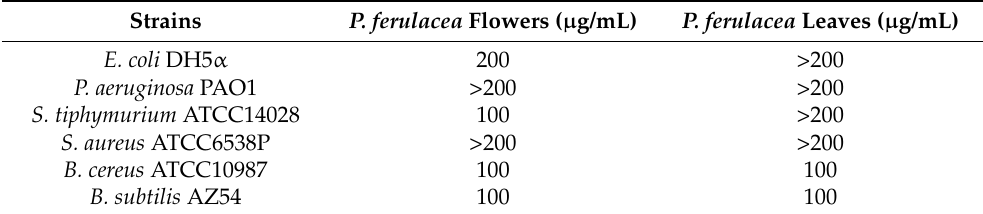
Table 2. Minimum inhibitory concentration values (MIC µ g/mL) of P. ferulacea oils against Gram- positive and Gram-negative bacteria. Values were obtained from a minimum of three independent experiments.